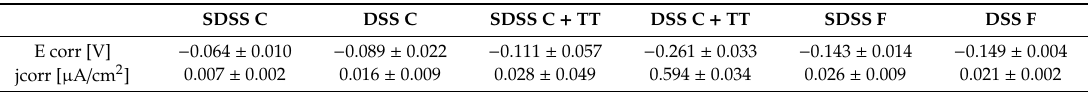
Figure 9. Potentiodynamic curves of DSS and SDSS samples as received (F), after the plasma carburizing process (C), after plasma carburizing and additional thermal treatment at 830 °C for a short time (C + TT). Table 2. Experimental parameters of corrosion potential and current density of the corresponding samples. Data are expressed as mean ± standard deviation (n = 3).